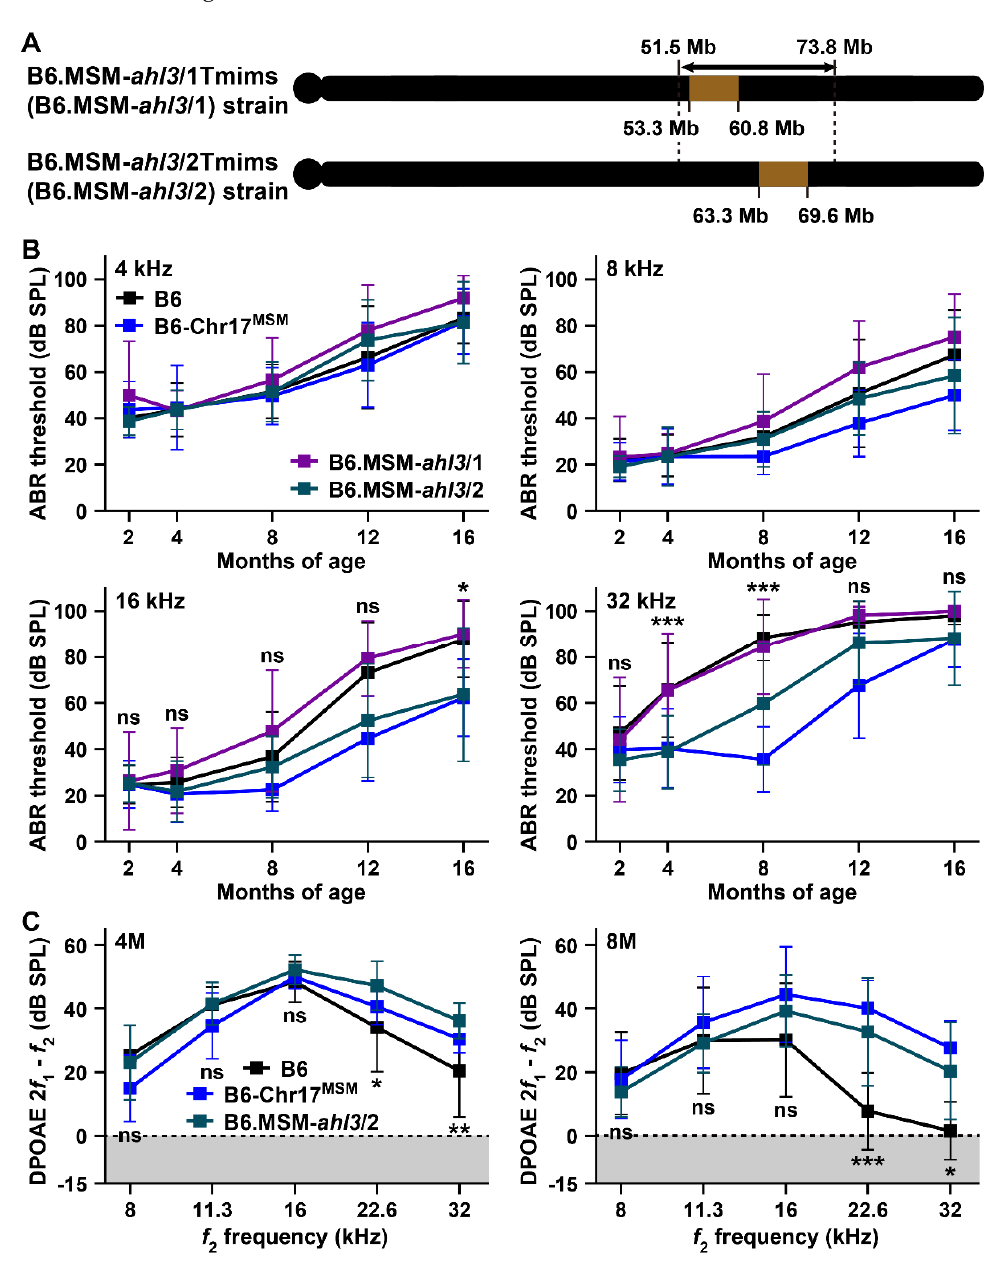
Figure 7. A B6.MSM- ahl3 congenic line exhibits delayed ARHL onset at middle- and high-frequency sounds: ( A ) Chromosomal structure of the B6.MSM- ahl3 /1Tmims (B6.MSM- ahl3 /1) and B6.MSM- ahl3 /2Tmims (B6.MSM- ahl3 /2) congenic lines. Black and light brown colors indicate recipient B6 and transferred MSM chromosomal regions in both congenic lines, respectively. The interval of the dou- ble-headed arrow shows the candidate region of the ahl3 locus estimated in the previous study [21]. ( B ) Comparison of the ABR thresholds at 4, 8, 16, and 32 kHz sound stimuli among male mice of the B6, B6-Chr17 MSM , B6.MSM- ahl3 /1, and B6.MSM- ahl3 /2 strains at 2 (B6, n = 15; B6-Chr17 MSM , n = 16; B6.MSM- ahl3 /1, n = 12; B6.MSM- ahl3 /2, n = 12), 4 (B6, n = 15; B6-Chr17 MSM , n = 15; B6.MSM- ahl3 /1, n = 14; B6.MSM- ahl3 /2, n = 12), 8 (B6, n = 14; B6-Chr17 MSM , n = 16; B6.MSM- ahl3 /1, n = 11; B6.MSM- ahl3 /2, n = 14), 12 (B6, n = 15; B6-Chr17 MSM , n = 18; B6.MSM- ahl3 /1, n = 11; B6.MSM- ahl3 /2, n = 15), and 16 (B6, n = 12; B6-Chr17 MSM , n = 12; B6.MSM- ahl3 /1, n = 11; B6.MSM- ahl3 /2, n = 11) months of age. ( C ) Comparison of DPOAE (2 f 1 - f 2 ) amplitudes against the f 2 frequencies at 8, 11.3, 16, 22.6, and 32 kHz among male mice of the B6, B6-Chr17 MSM , and B6.MSM- ahl3 /2 strains at 8 (B6, n = 14; B6-Chr17 MSM , n = 11; B6.MSM- ahl3 /2, n = 10) and 12 (B6, n = 15; B6-Chr17 MSM , n = 12; B6.MSM- ahl3 /2, n = 12) months of age. The means (squares) and SDs (error bars) of the ABR thresholds and DPOAE amplitudes are shown. The noise floors (gray zones) are adjusted to 0 dB SPL. Two-way ANOVA revealed